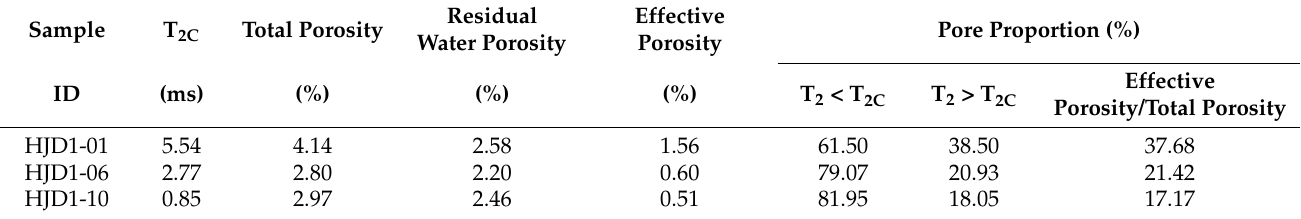
Table 3. Results of NMR